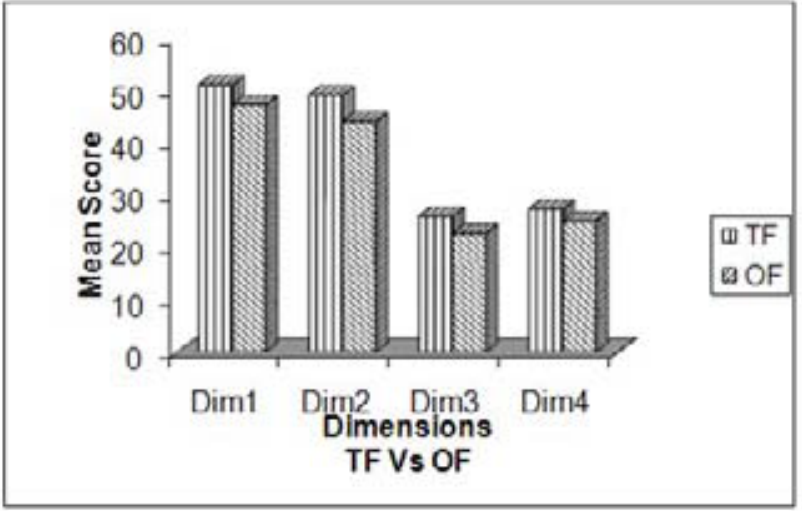
Figure 5 . Dimension-wise comparison of mean values for academic motivation of TES and OES female